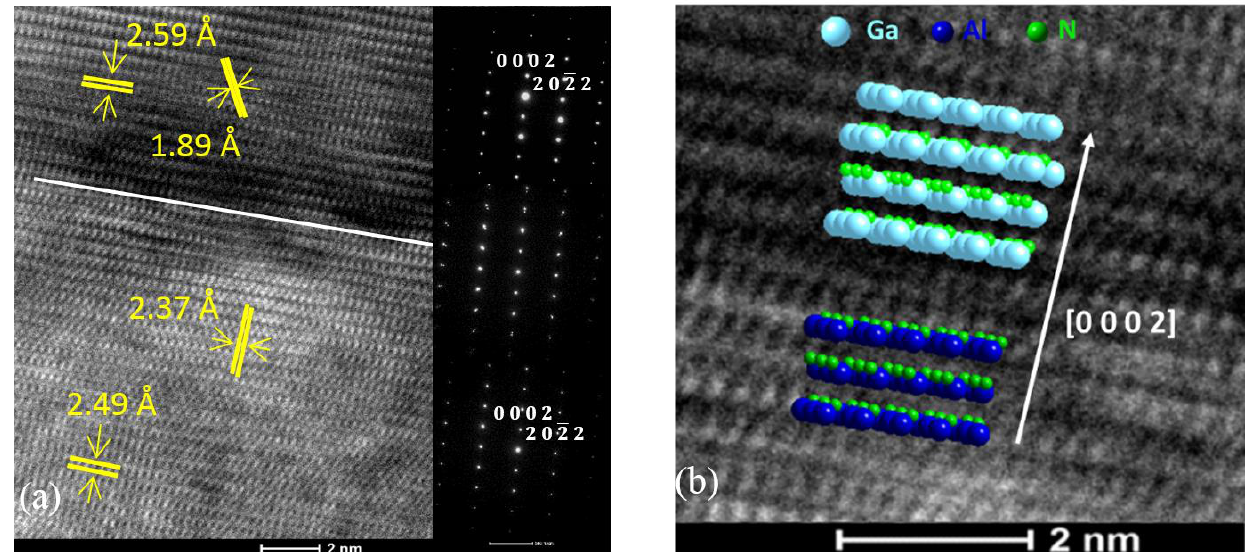
Figure 2. ( a ) HR-TEM micrographs and SAED patterns depicting the atom planes in AlN and GaN with respect to their interface; ( b ) HR-TEM micrographs overlaid with simulated crystal lattices near the interface between the AlN substrate and GaN buffer layer.